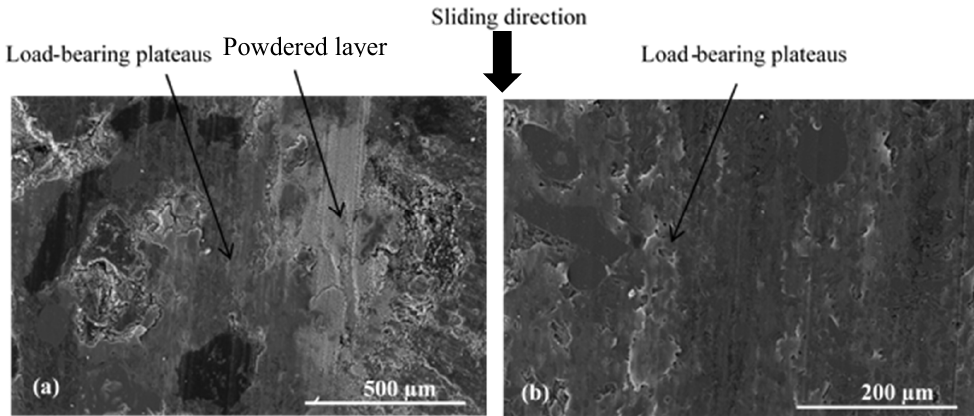
Figure 11. Open contact area and load-bearing zone at the OR for FMFS (SEM, mode SE) showing ( a ) powdered layer and ( b ) extended load-bearing plateaus.